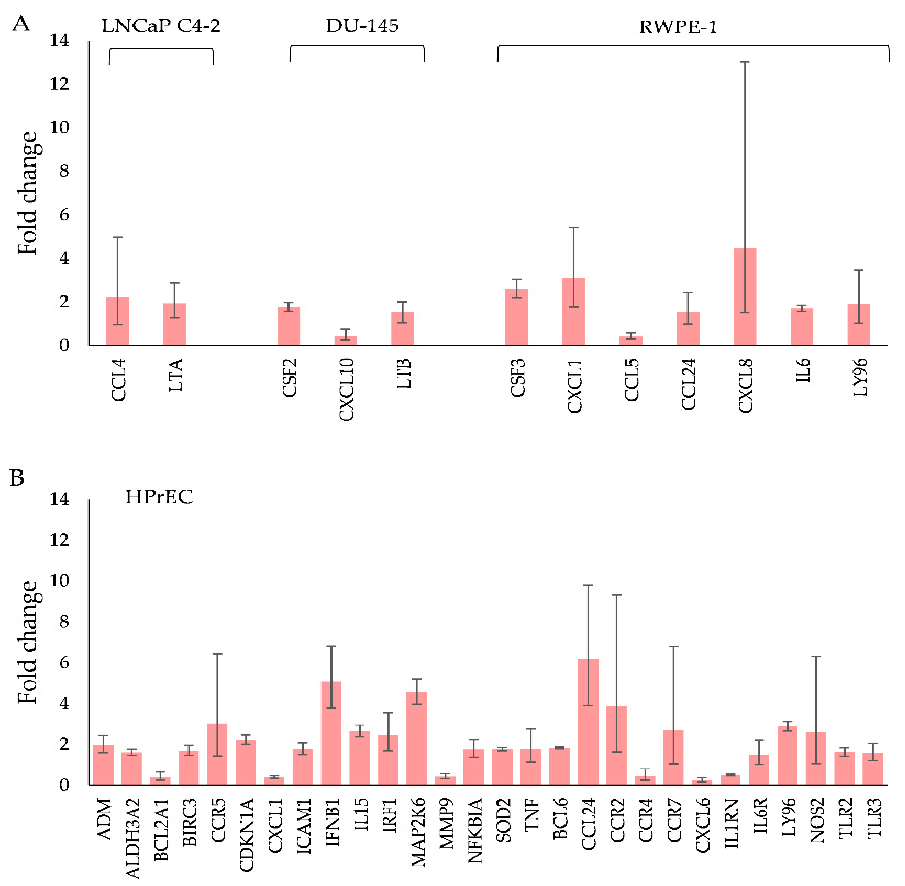
Figure 6. Statistically significant changes in NF- κ B signaling and in the inflammatory response and autoimmunity gene expression with a cut-off value for gene expression fold changes >1.5 in ( A ) LNCaP C4-2, DU-145 cells, RWPE-1 and ( B ) HPrEC cells after treatment with 50 mcg mL − 1 of NaA-silane-PEG-D2B for 96 h. Mean fold change values from three independent experiments are presented. Error bars represent a 95% confidence